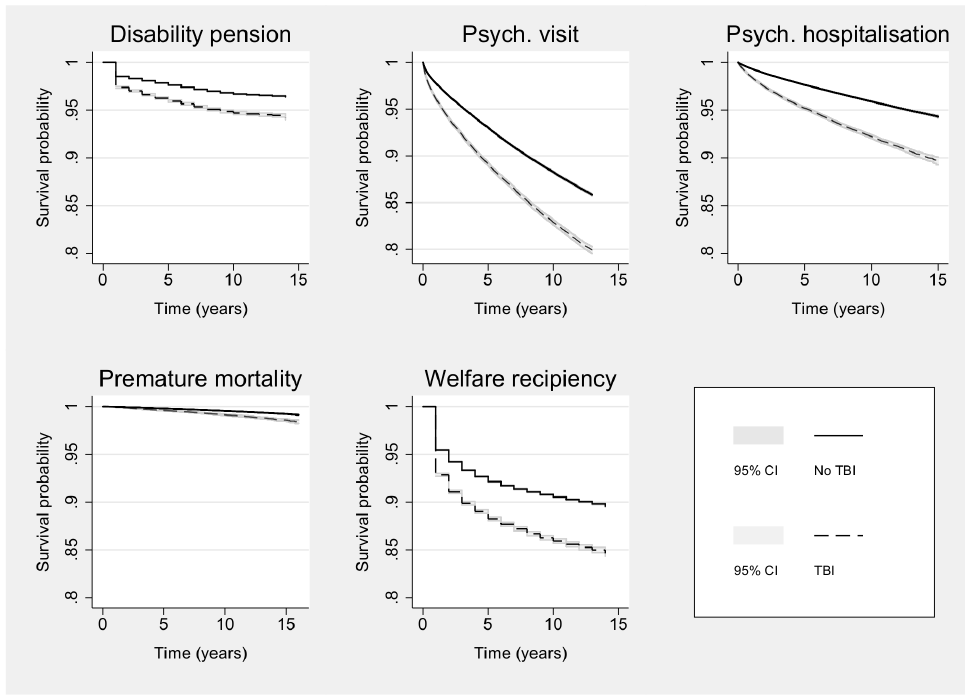
Fig 1. Kaplan-Meier survival curves for all right-censored outcomes across TBI exposure before age 25 y.